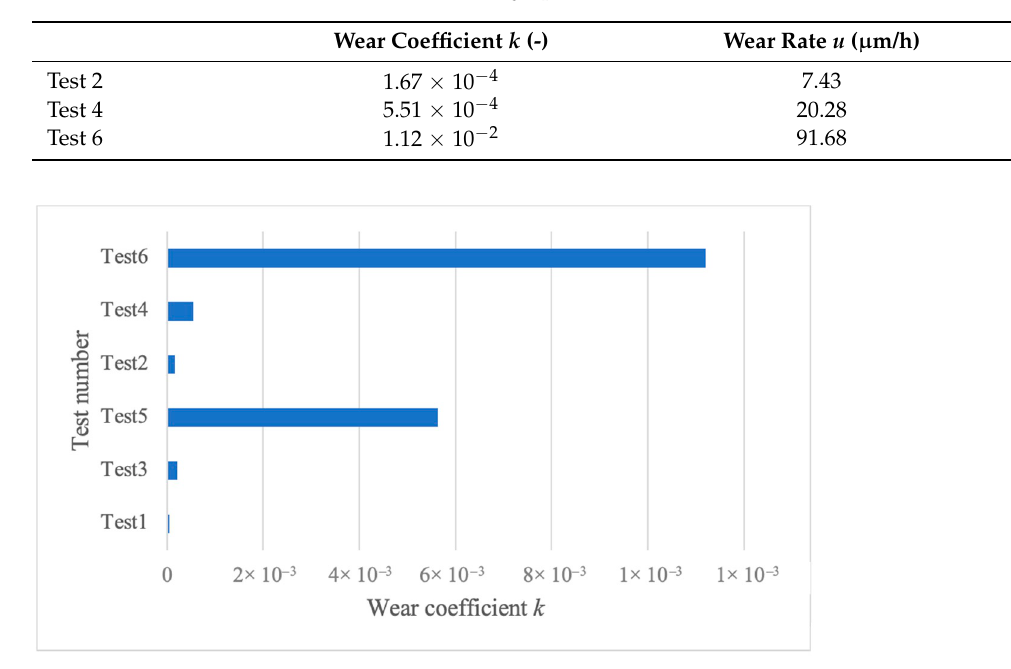
Figure 13. Wear coefficient k of Si 3 N 4 balls.